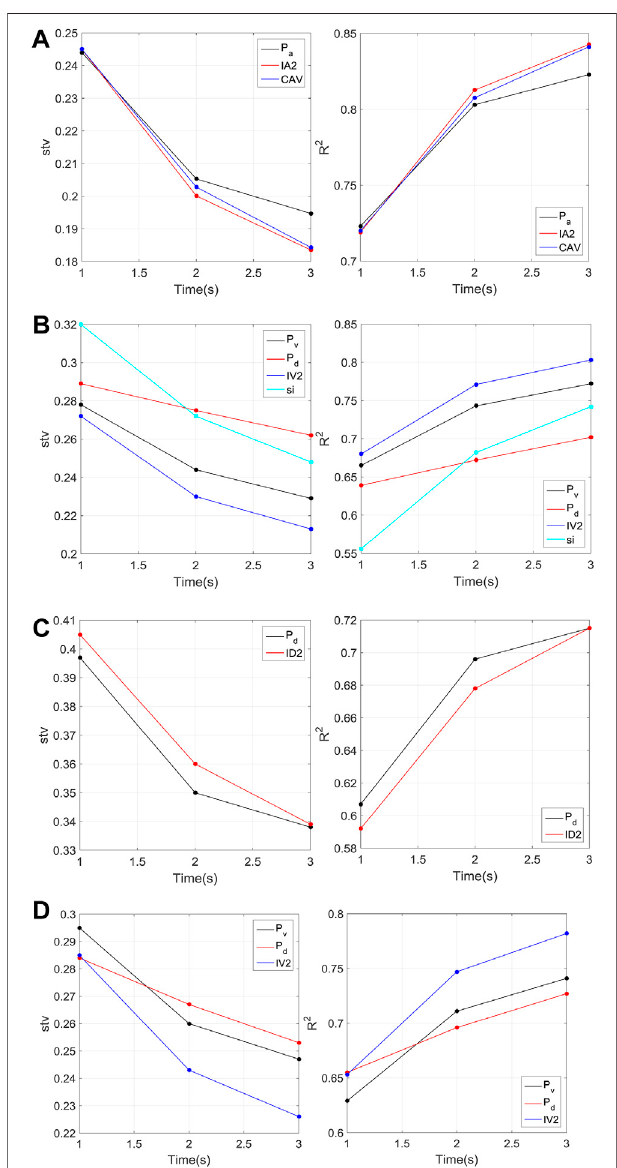
FIGURE 6 | Comparison of the standard deviation and coef fi cient of determination between the leading parameters for estimating (A) PGA, (B) PGV, (C) PGD, and (D) SI, respectively.